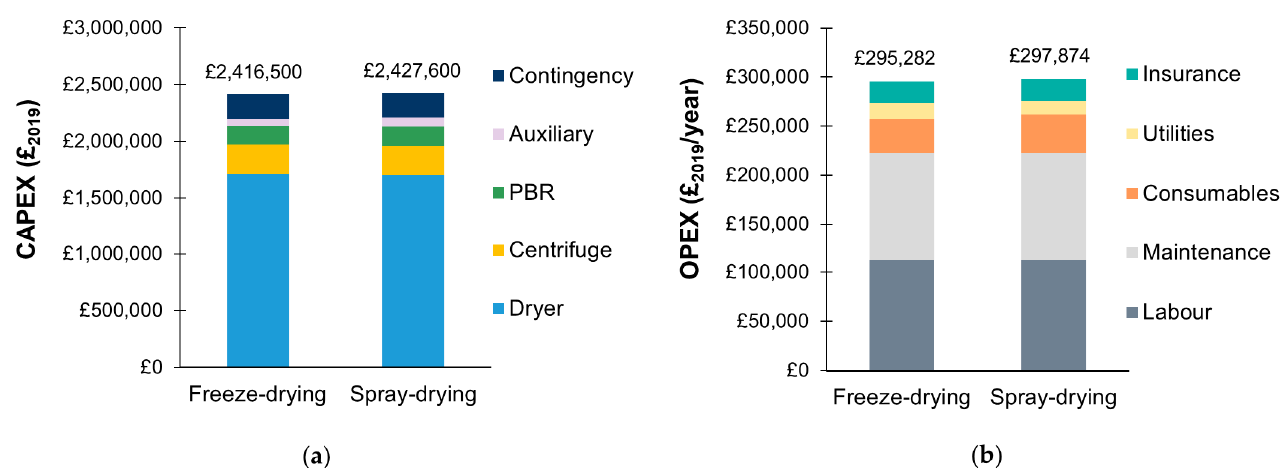
Figure 5. Details of the ( a ) capital expenditures (CAPEX) and ( b ) operating expenditures (OPEX) for the production of a microalgae-based edible vaccine with a freeze-drying or spray-drying strategy. An annual production of 286 kg DCW of microalgae is considered with a vaccine yield of 3.15 g vaccine /kg DCW (base case scenario).